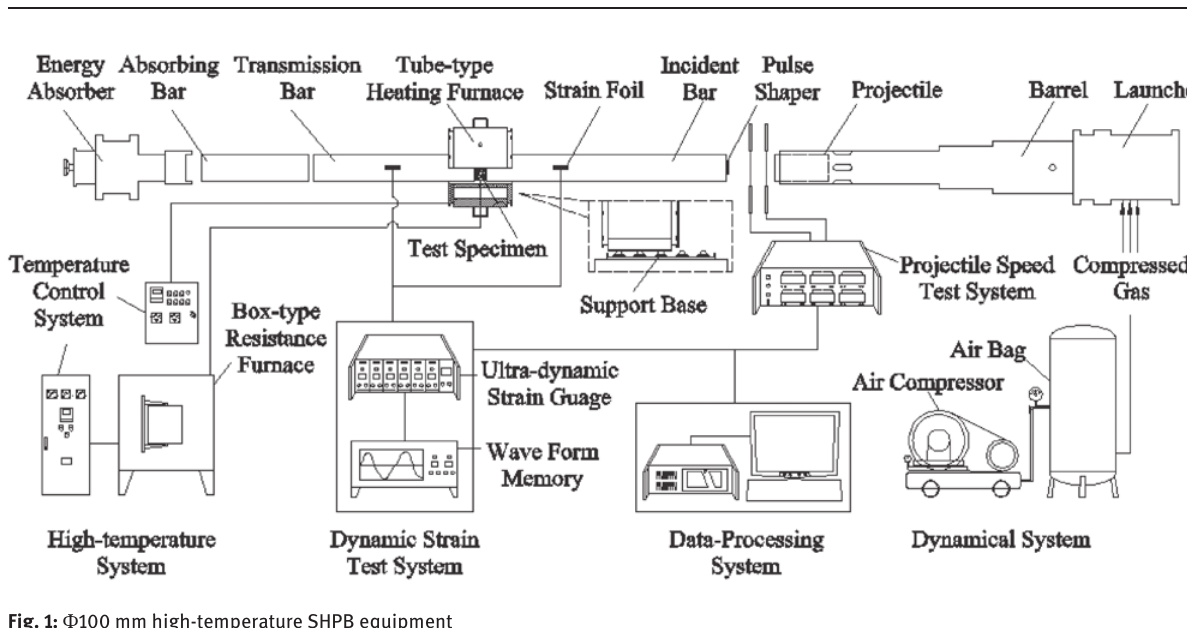
Fig. 1: Φ 100 mm high-temperature SHPB equipment